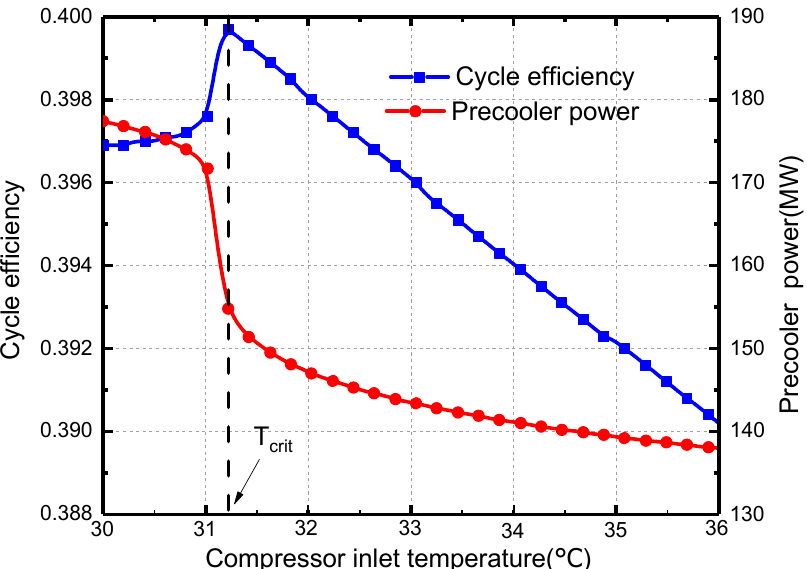
Figure 5. Cycle e ffi ciency versus minimum Figure 5. Cycle efficiency versus minimum temperature.